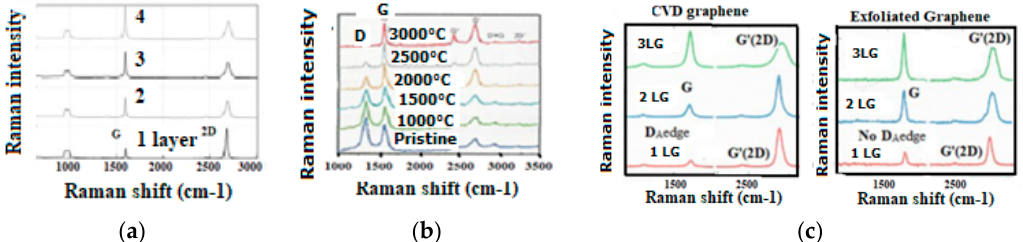
Figure 11. Raman spectroscopy of di ff erent quality of graphene. ( a ) High temperature longer time annealed graphene by Watanabe et al. [218] with permission of Diamond and Related Materials. No GeA peak (so-called “D disorder”). ( b ) Annealed graphene by J. Campos Delgado [172] with permission of Chemical Physics Letters suggesting many defects left, even after annealing. ( c ) Raman spectra by A. Reina et al. [219] with permission of Nano letters, showing no D disorder peak (GeA), sharp 2D and G on 1 L/2 L indicating reduced disorder for the exfoliated graphene and some disorder for the CVD graphene with broader G and G’ (2D) sheet without C5/C7 ring formation.